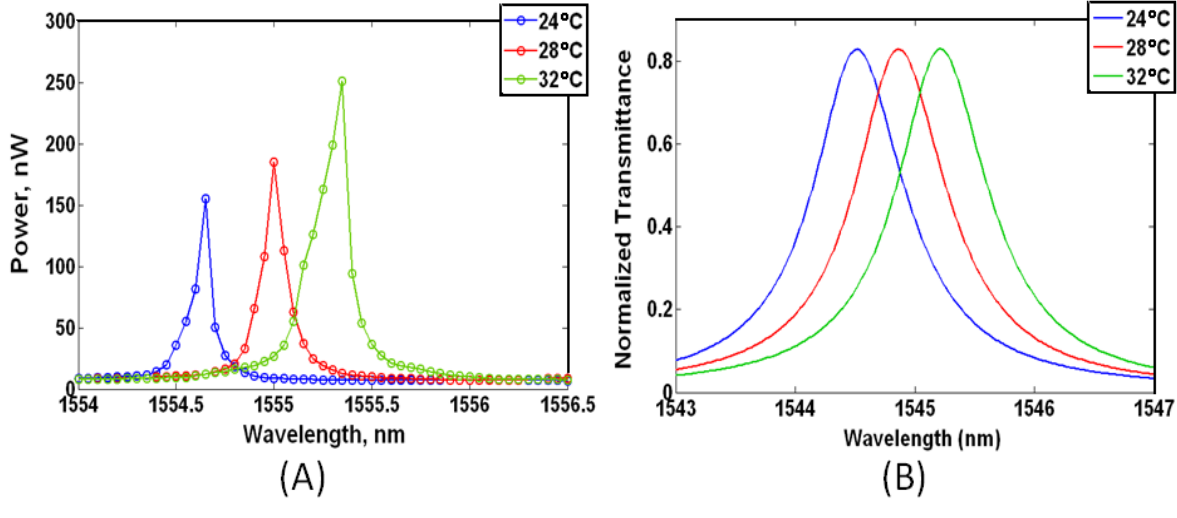
Figure 4. ( A ) Measured resonance shift in air of a ring resonator; ( B ) Simulated shift of a ring resonator clad in air as a function of rising temperature.